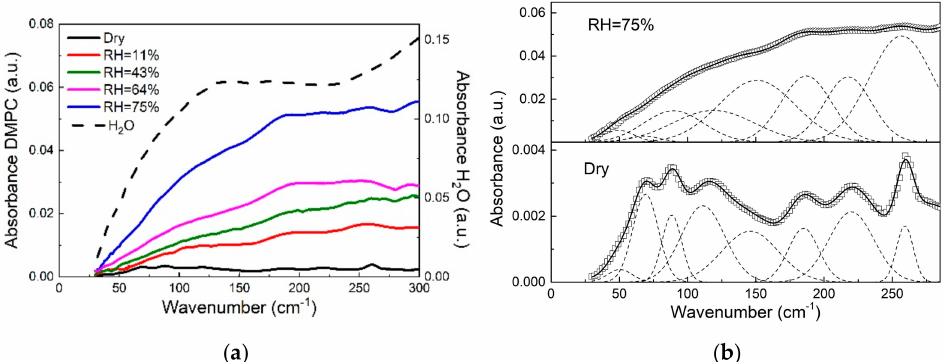
Figure 2. Far-infrared spectra of the DMPC/H 2 O samples. ( a ) Spectra of pure water (dashed black line) and of the samples at five distinct hydration degrees: dry (black full line), RH = 11% (red), RH = 43% (green), RH = 64% (magenta), and RH = 75% (blue); ( b ) The spectra of the dry sample and of a wet sample (RH = 75%) are shown separately with the corresponding fitting curve (solid black line) obtained as the sum of the individual Gaussian peaks (dashed black